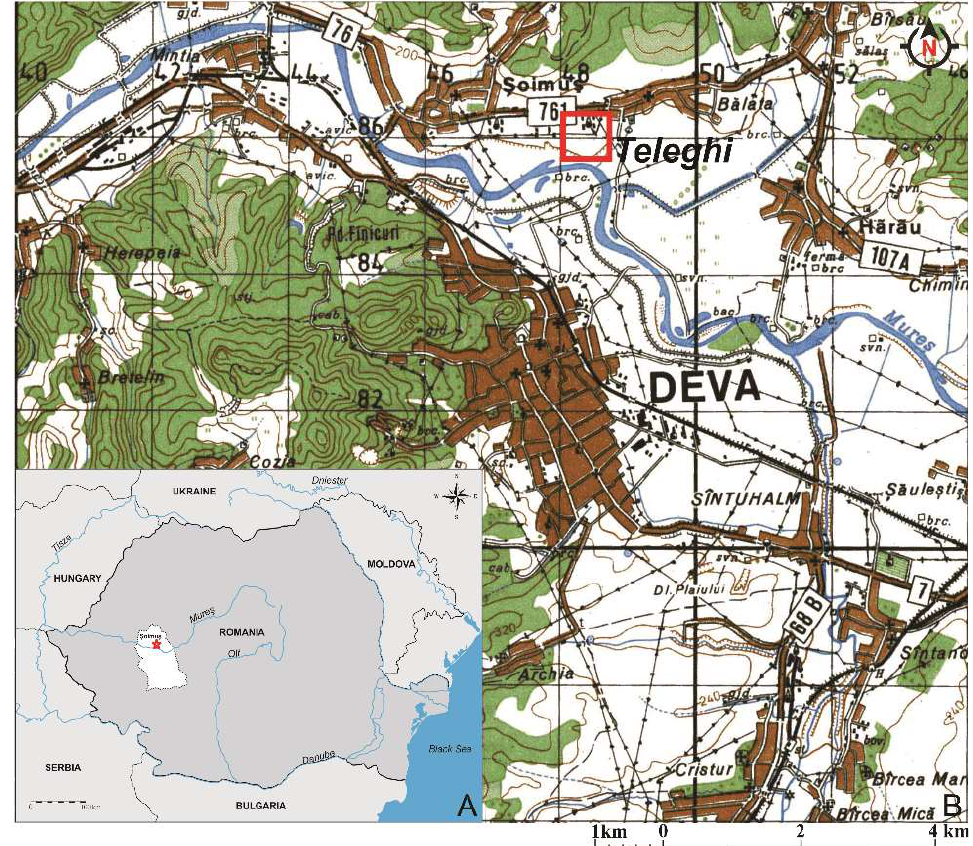
Figure 1. Location of Şoimuş village (red star) within the territory of Romania ( A ); Teleghi site (red square) on the topographic map (1996) and surrounds ( B ).